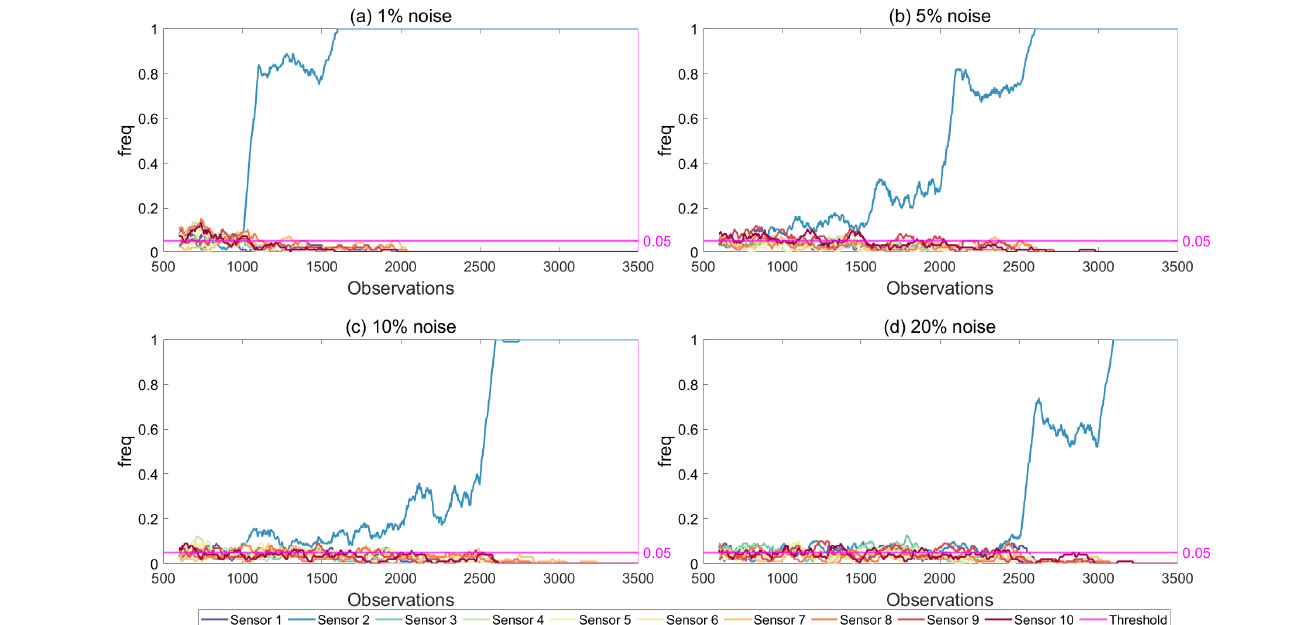
Figure 17. Frequency of exceedance using modal strain energy with two modes for different noise levels, increasing damage at quarter-span (location 2) and 5%